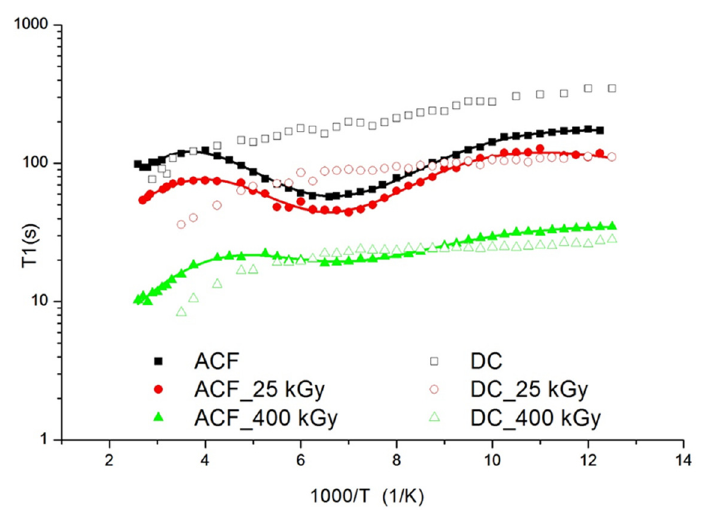
fitted to a single exponential function M(t) = M0 (1 - exp( − t/T1) to within experimental error, where M0 was the equilibrium value, and T1 was the spin-lattice relaxation time. pendence of the spin-lattice relaxation times T1 for aceclofenac (AC) and diclofenac (DC) was shown in Figure 8.